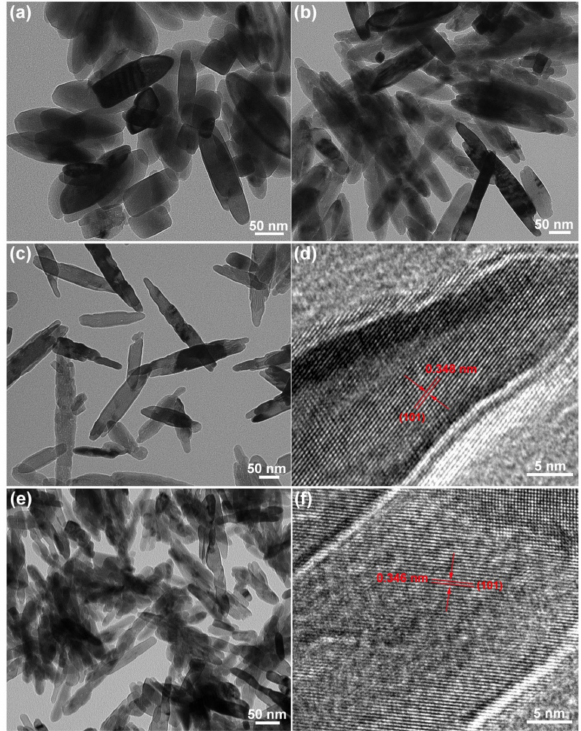
Figure 3. TEM and HRTEM pictures of TiO 2 photocatalysts obtained with different content of TEA: ( a ) T10, ( b ) T20, ( c , d ) T30, and ( e , f )